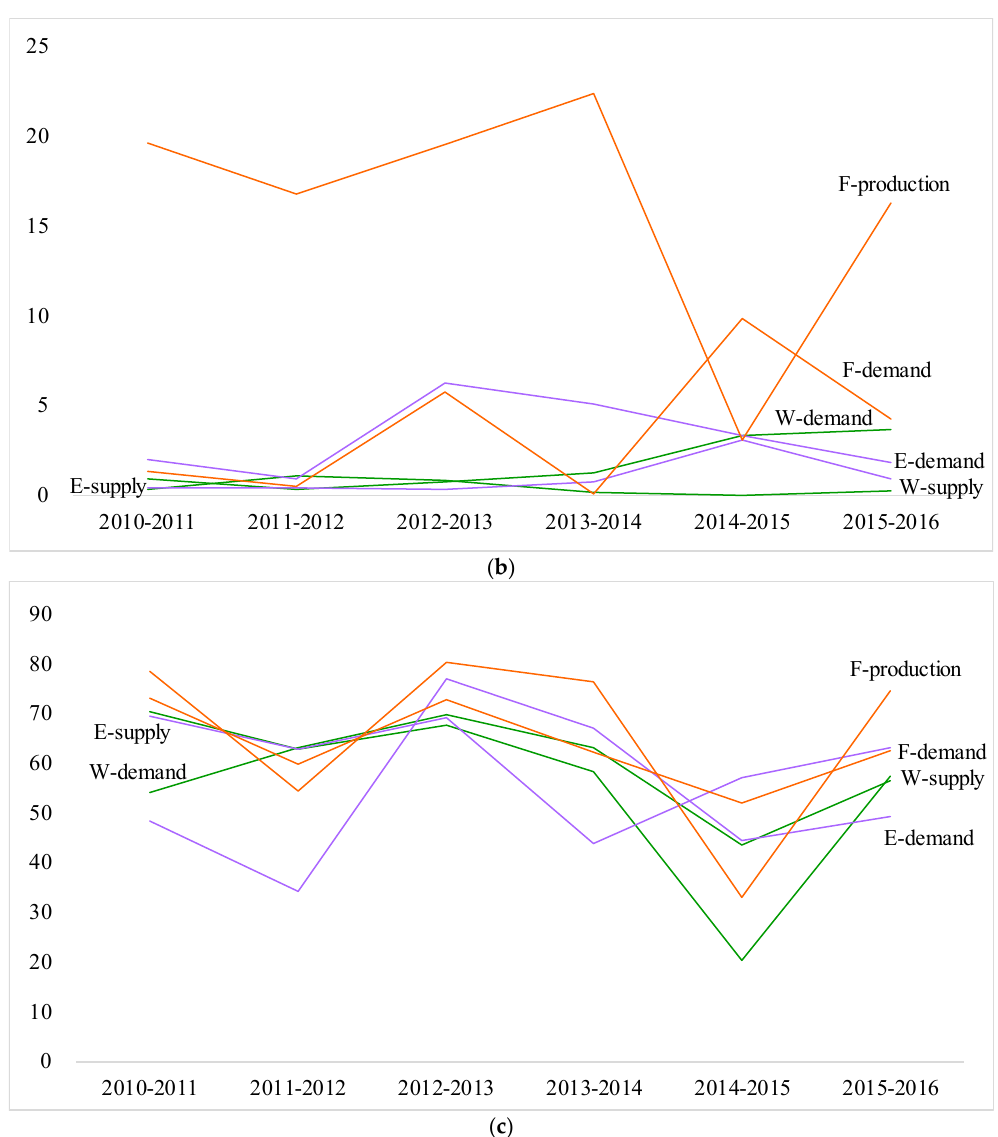
Figure 4. ( a ). Degree centrality of synergetic network from 2010 to 2016; ( b ). Betweenness centrality of synergetic network from 2010 to 2016; ( c ). Closeness centrality of synergetic network from 2010 to 2016.